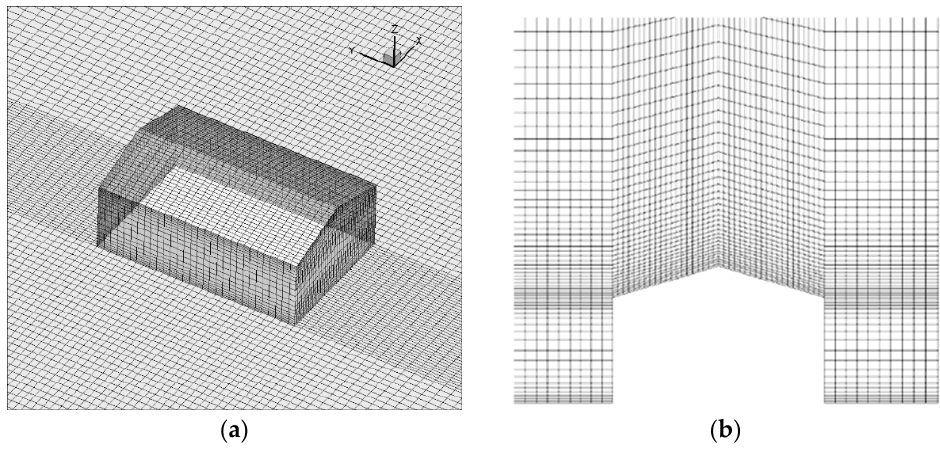
Figure 10. Comparison of numerical simulations and field measurement: ( a ) streamwise direction; ( b ) lateral direction.